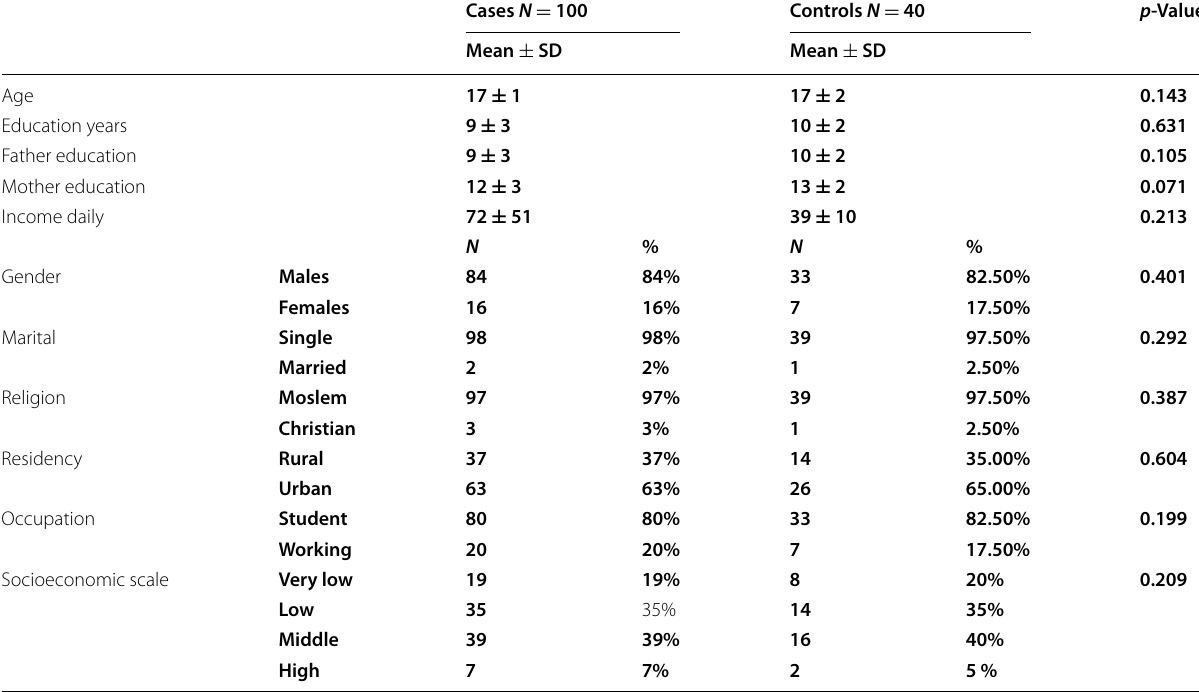
Table 1 Sociodemographic variables